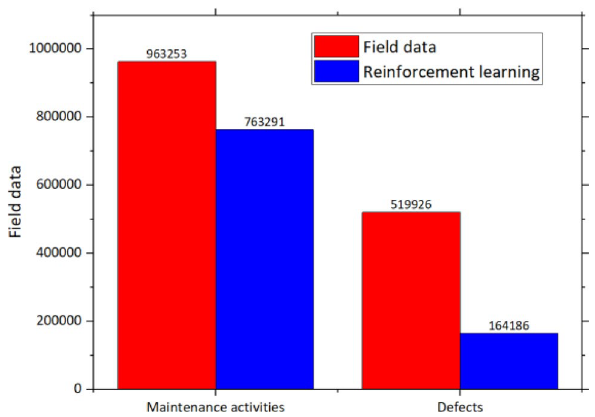
Figure 10. The number of maintenance activities and defects from field data and reinforcement learning model.